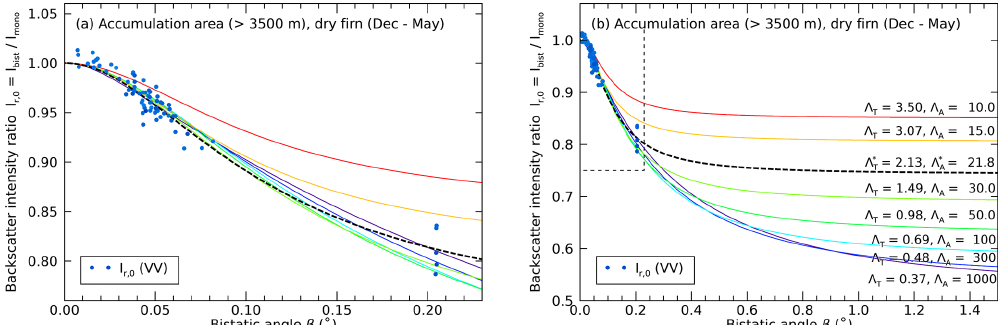
Figure 12. (a) Backscatter ratios ˆ I r, 0 (β) (dots) restricted to dry firn observations in winter (1 December–31 May; I mono > − 8dB) in the accumulation areas of the Jungfrau–Aletsch region from TanDEM-X at VV polarization. Colored lines indicate different CBOE model curves, Eq. (13), parametrized by a range of scattering and absorption parameter combinations ( (cid:51) T , (cid:51) A ) that can describe the data to different degrees. (b) Same as (a) (in dashed box) but zoomed out to visualize at which β values the different model fits converge to the flat region of the intensity curve I r , 0 (β → ∞ ) where coherent backscatter enhancement is negligible. Measurements at larger bistatic angles of β > 0 . 5 ◦ could substantially better constrain the total peak height (and thereby (cid:51) A ), but such large angles are currently not